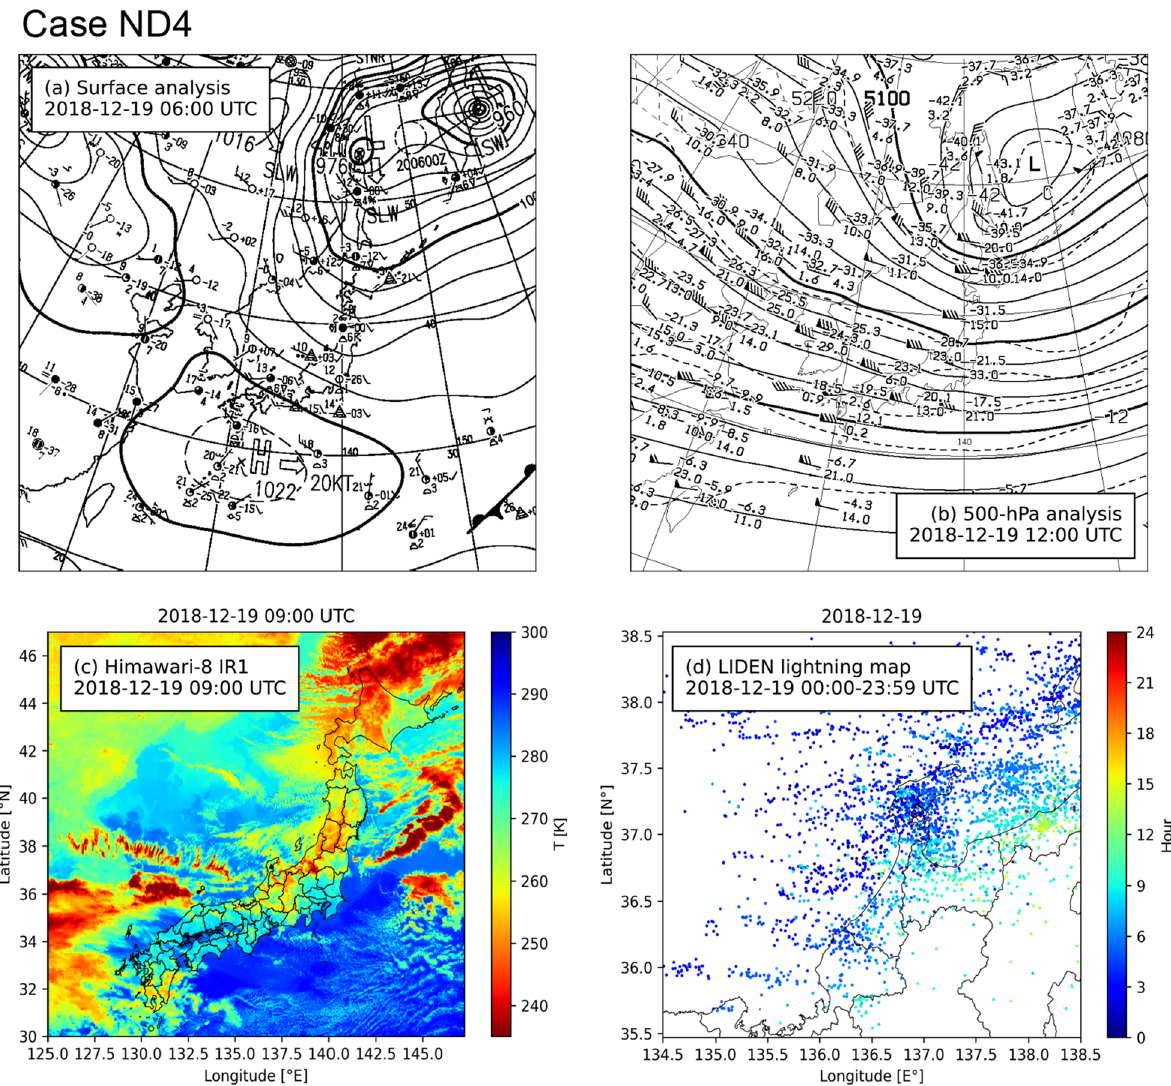
Fig. 12 Meteorological charts of the non-detection case ND4 in the same format as Fig.